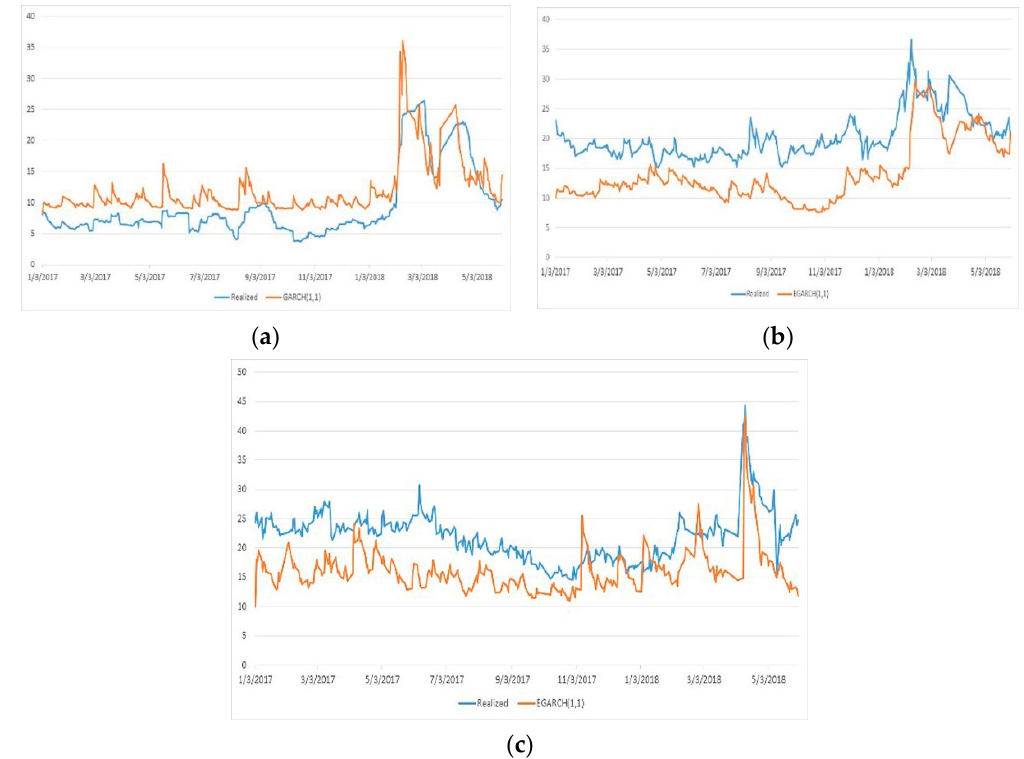
Figure 2. Realized Volatility vs. Volatilities Estimated with the Superior Volatility Models– Out-of-Sample Period: ( a ) for S&P 500. ( b ) for SSEC. ( c ) for MICEX.